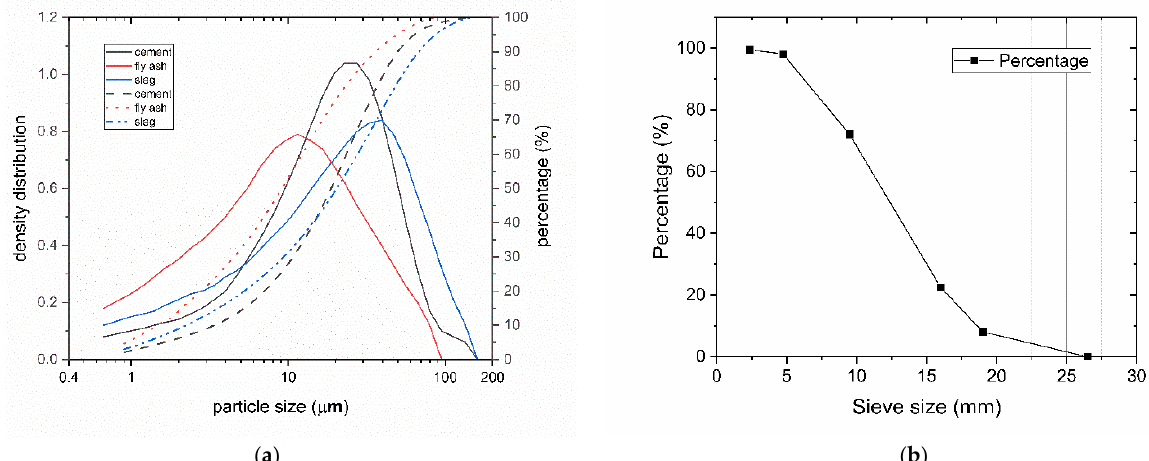
Figure 1. ( a ) Particle size distribution of cement, fly ash, and slag. Solid lines show the cumulative distribution, and dotted lines show the density distributions. ( b ) Gradation curve of coarse